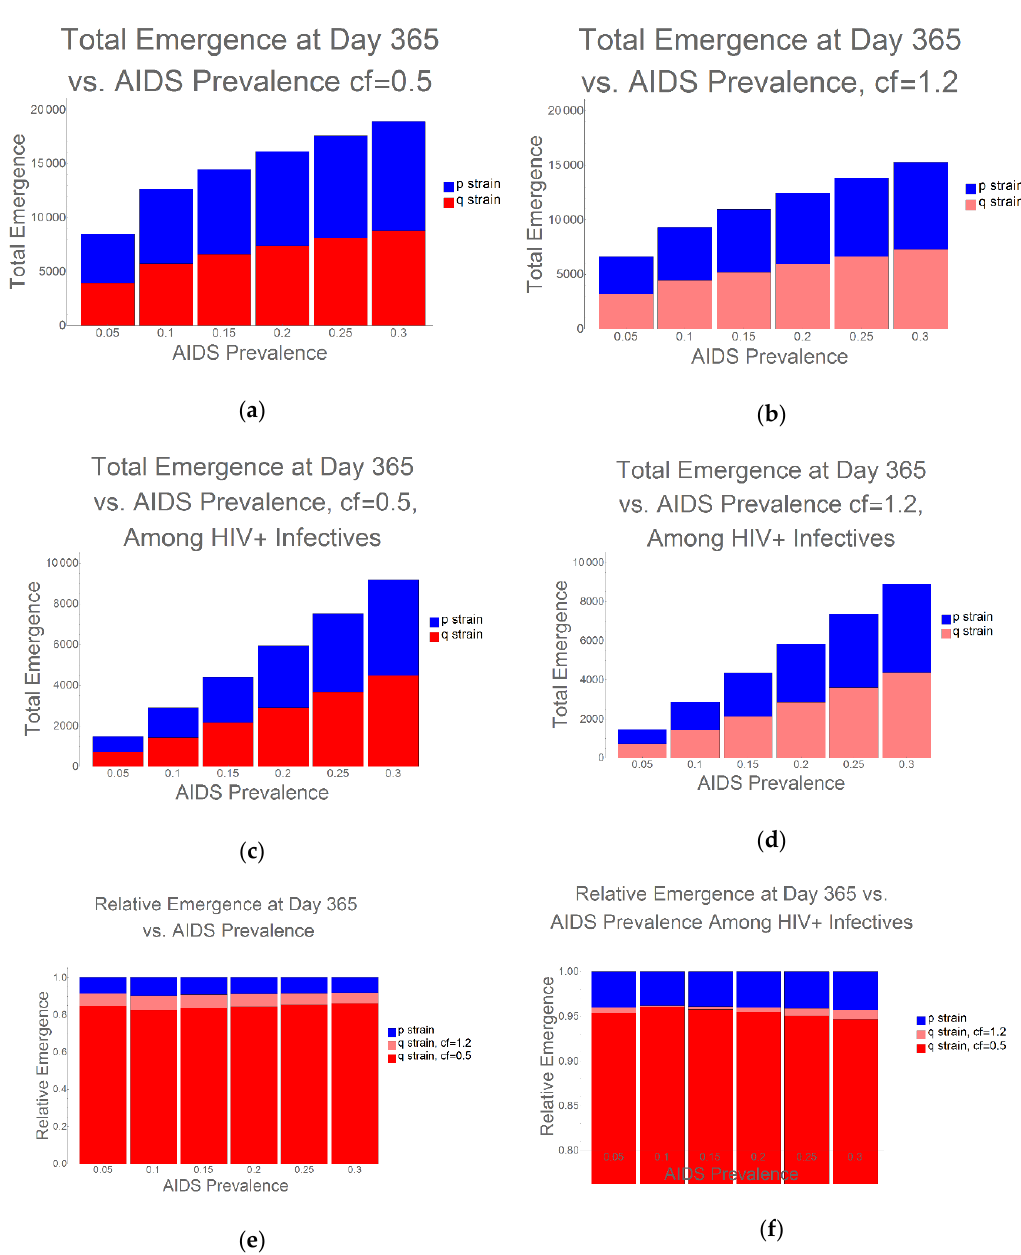
Figure 3. Ratios of Emergence as HIV/AIDS Prevalence Increases: We investigated the emergence and dominance of resistant strains as HIV/AIDS prevalence increased from 0%-30%, and we present results for the entire population, and for HIV/AIDS+ hosts only. Irrespective of the initial fitness of the q-strain, we observe increasing q-strain success as HIV/AIDS prevalence increases. ( a,b ) Emergence in the total population with ( a ) cf = 0.5 and ( b ) cf = 1.2; ( c,d ) Emergence in the HIV+ infective population with ( c ) cf=0.5 and ( d ) cf=1.2; ( e,f ) Relative emergence among ( e ) total population and ( f ) HIV+ infectives.